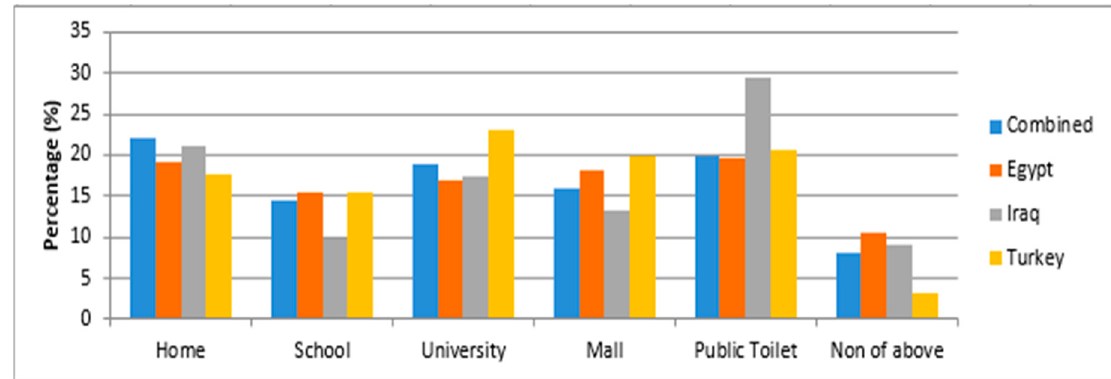
Figure 3. Preferred locations to install UDT.